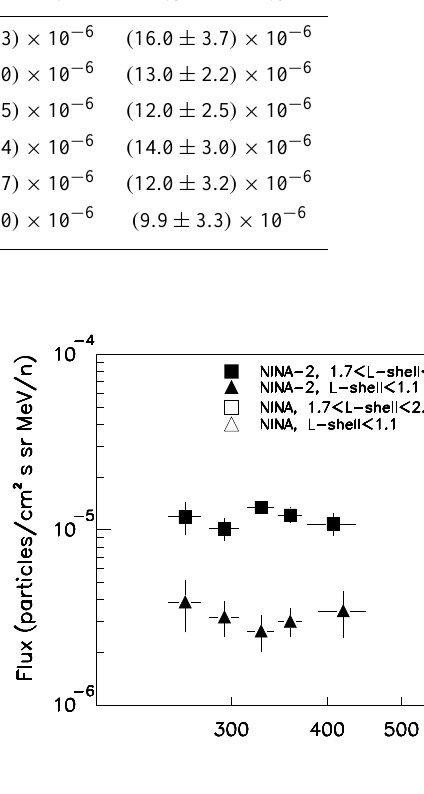
Fig. 3. Secondary proton flux as a function of altitude, as mea- sured by NINA and NINA-2. Open points: data taken by NINA at B > 0.23 G. Solid points: data taken by NINA-2 at B > 0.26G. Squares: data for 1 . 7 < L-shell < 2 . 6. Triangles: data for L- shell < 1 .